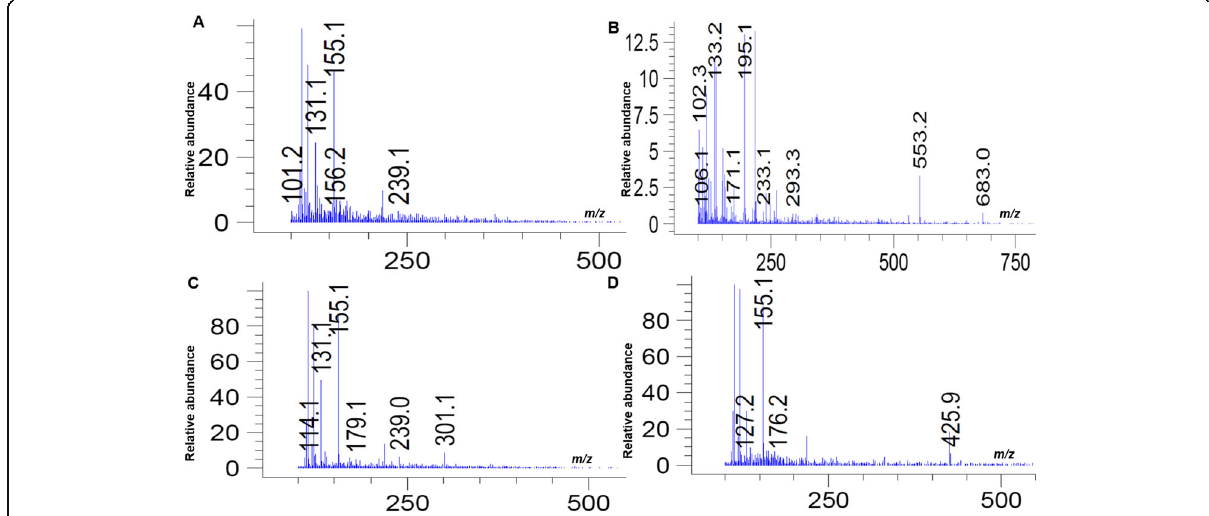
Fig. 2 Mass spectra of different ion peaks of fraction 14 at different R t showing the detection of components with different m/z values. a Mass spectrum at R t = 2.00 min. b Mass spectrum at R t = 2.92 min. c Mass spectrum at R t = 14.75 min. d Mass spectrum at R t = 19.76 min